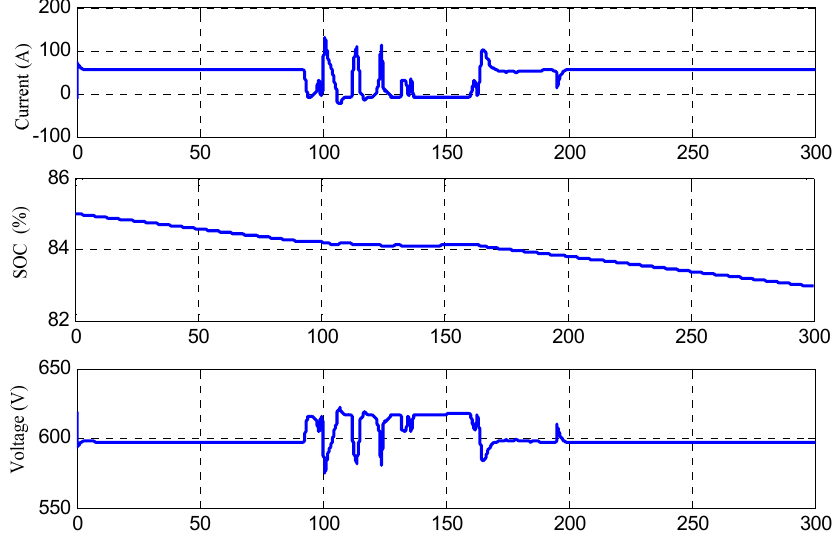
Figure 20. Battery characteristics for Case